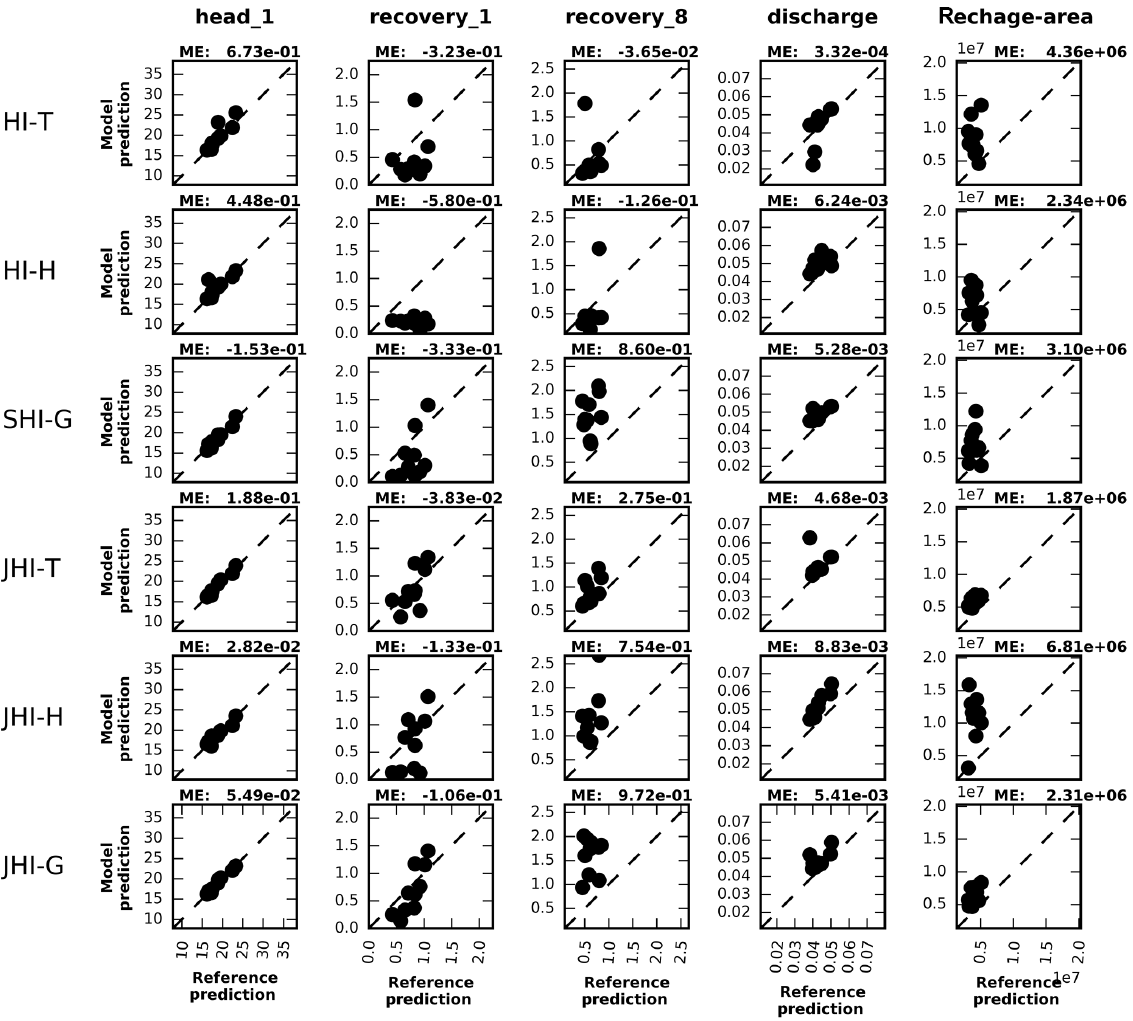
Figure 7. Scatterplots of calibrated model prediction versus reference prediction for five predictions (explained in the body text). Each plot shows results from ten system